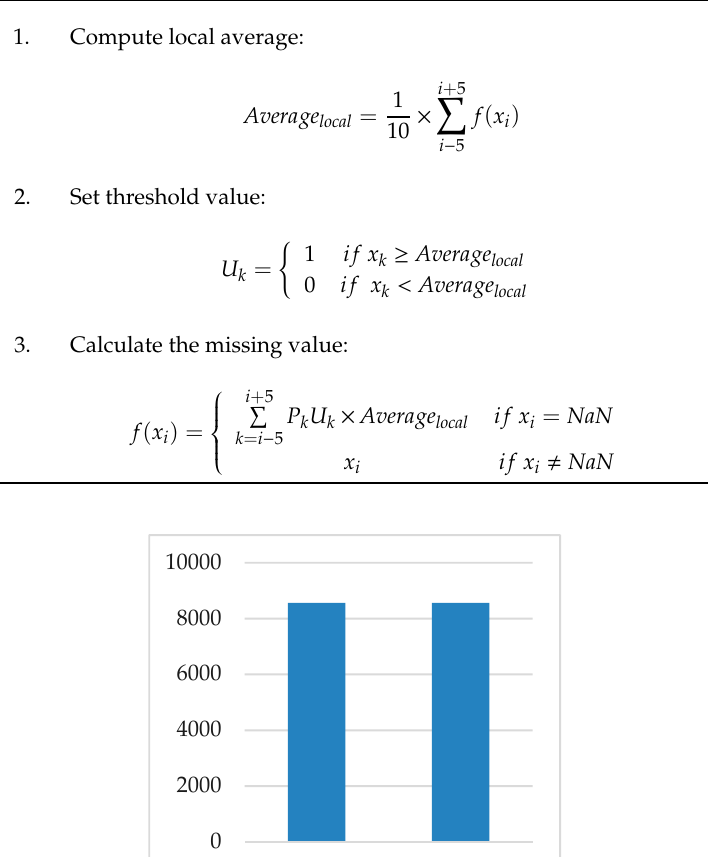
Algorithm 1: Data Pre-processing Algorithm